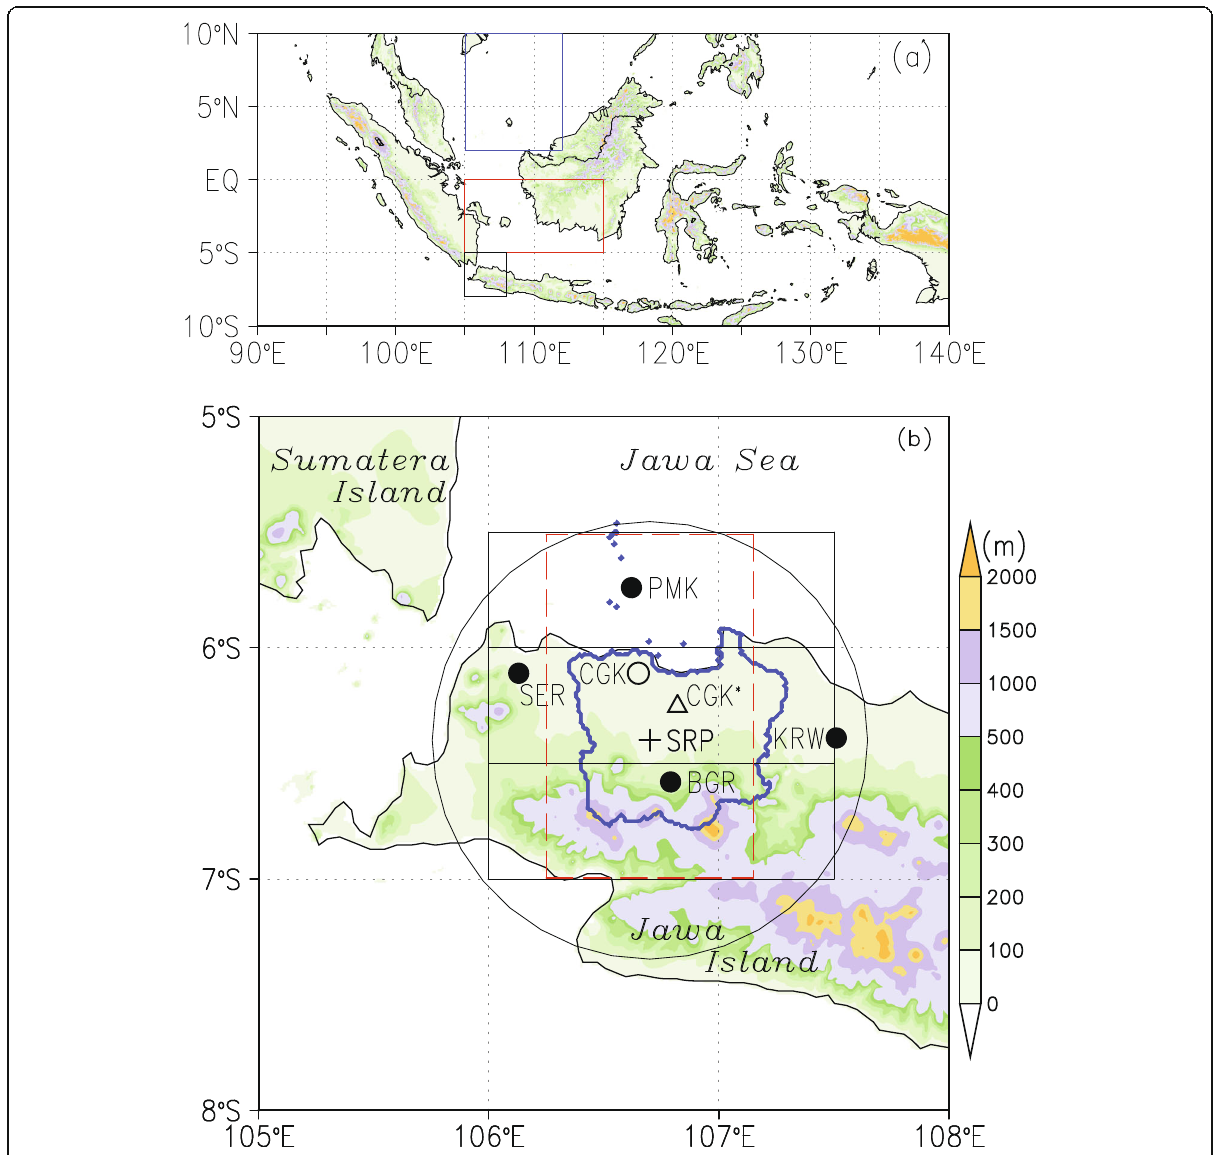
Fig. 1 Area of study for the HARIMAU2010 campaign. a Topographical maps of Indonesia and b the western part of Jawa Island. Rectangles in black, red, and blue solid lines in panel a indicate a location in panel b , definition areas for CENS (5.0° S – EQ, 105° E – 115° E), and definition areas for CT (2° N – 10° N, 105° E – 112° E), respectively. The four closed black circles indicate the sounding stations used in the present study: PMK, SER, KRW, and BGR stand for Pramuka, Serang, Karawang, and Bogor, respectively. A small open circle shows the location of the Cengkareng (CGK) BMKG meteorological station for the Jakarta Soekarno – Hatta International Airport. The middle point between Serang and Karawang is indicated as Cengkareng* (CGK*) with an open triangle, and it was used for the analyses in Figs. 7 and 9. SRP with a plus sign stands for Serpong, where both the C-band Doppler radar (CDR) and wind profiling radar (WPR) are installed; the large open circle indicates the observational range (105 km in radius) of the CDR volume scan mode. Large three rectangles depicted by solid black lines over Jakarta (106.0° E – 107.5° E) indicate the areas for GSMaP rain analyses in Fig. 3, which included coastal sea (6.0° S – 5.5° S), land (6.5° S – 6.0° S), and mountain foothill (7.0° S – 6.5° S) regions. The rectangle depicted by the dashed red lines indicates the area (7.0° S – 5.5° S, 106.25° E – 107.15° E) for CDR data analyses in Figs. 6, 7, 8, and 9. The area surrounded by a solid blue line shows the “ greater Jakarta ” region (Jakarta city and surrounding urban agglomerations of Jakarta, Bogor, Depok, Tangerang, and Bekasi (JABODETABEK); hereafter, just referred to as tongue (CT) of SST over the South China Sea (SCS) in model simulations have been utilized to diagnose inter- generating active convections at the land-breeze front, actions between local winds, namely, land – sea circula- in particular for nocturnal heavy precipitation around tions and diurnally developed convections over Jakarta, the coastal region (Trilaksono et al. 2011, 2012; Koseki and the results implied a vital role of the CENS or cold